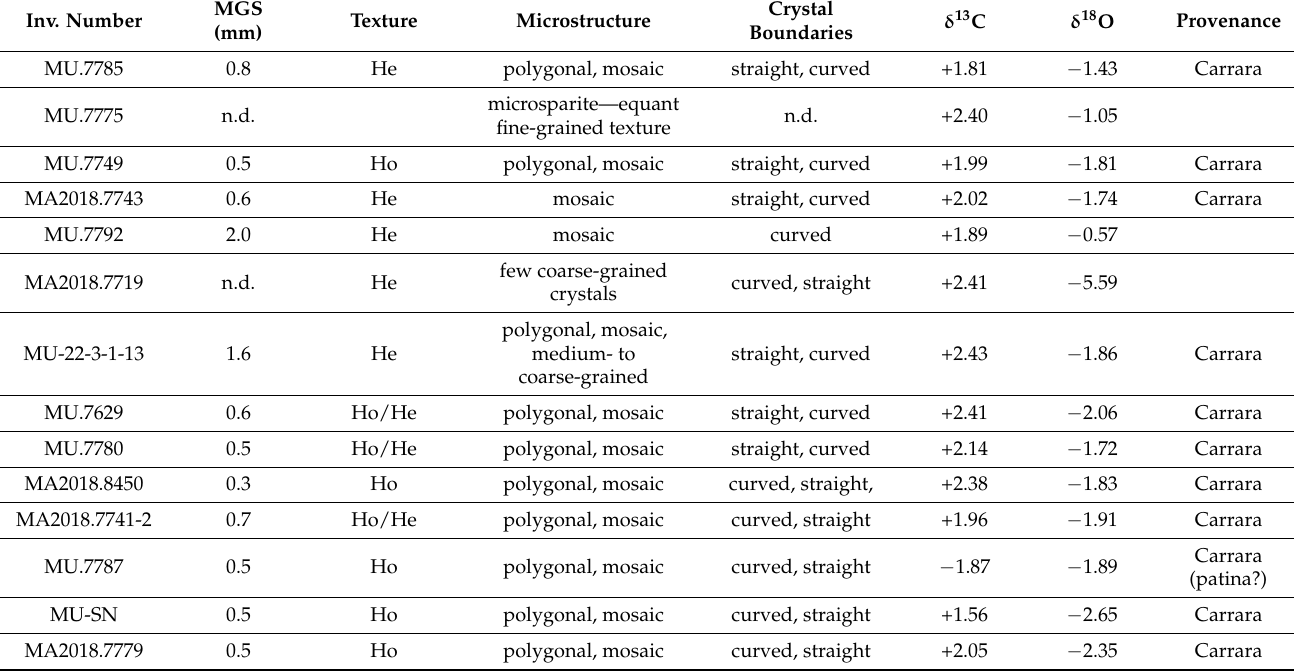
Table 1. Mineralogical–petrographic features from thin section observations, isotopic values, and resultant provenance interpretation of the gray/white marbles of the inscriptions. Petrographic data: Ho—homeoblastic; He—heteroblastic; n.d.—not